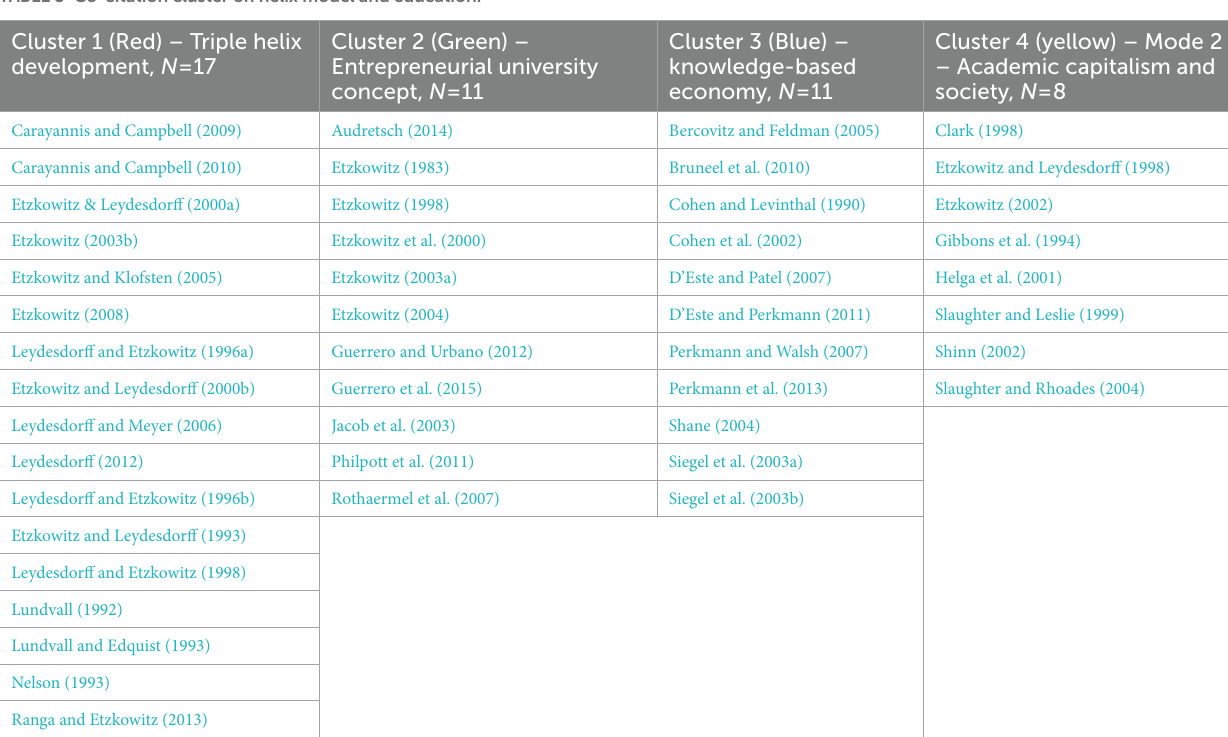
TABLE 3 Co-citation cluster on helix model and